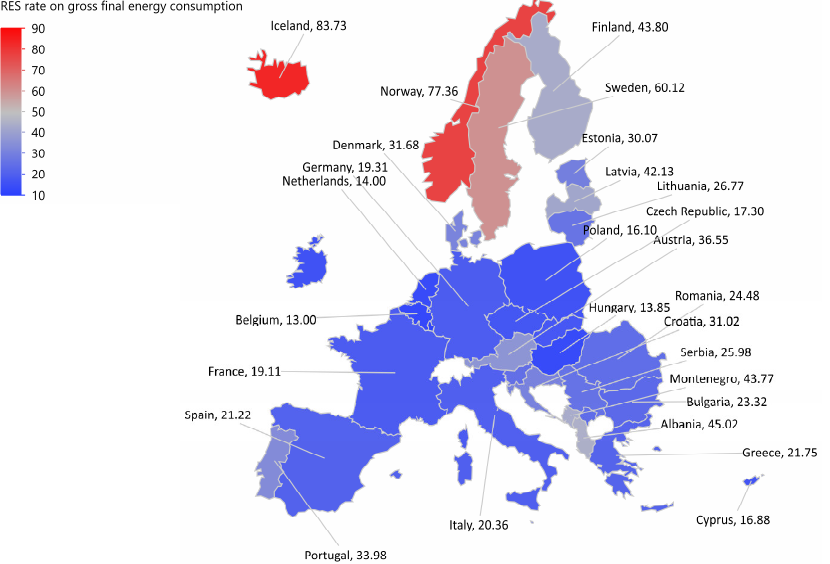
Figure 9. Cartographic representation of RES rate on gross final energy consumption in 2020. Source: own processing according to [21], processing in JMP.